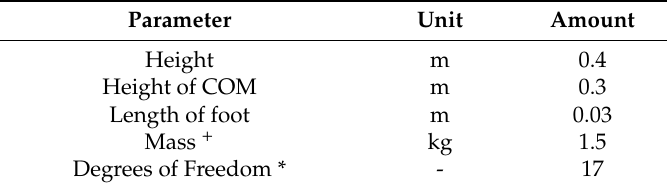
Table 1. KONDO KHR-3HV robot physical parameters.